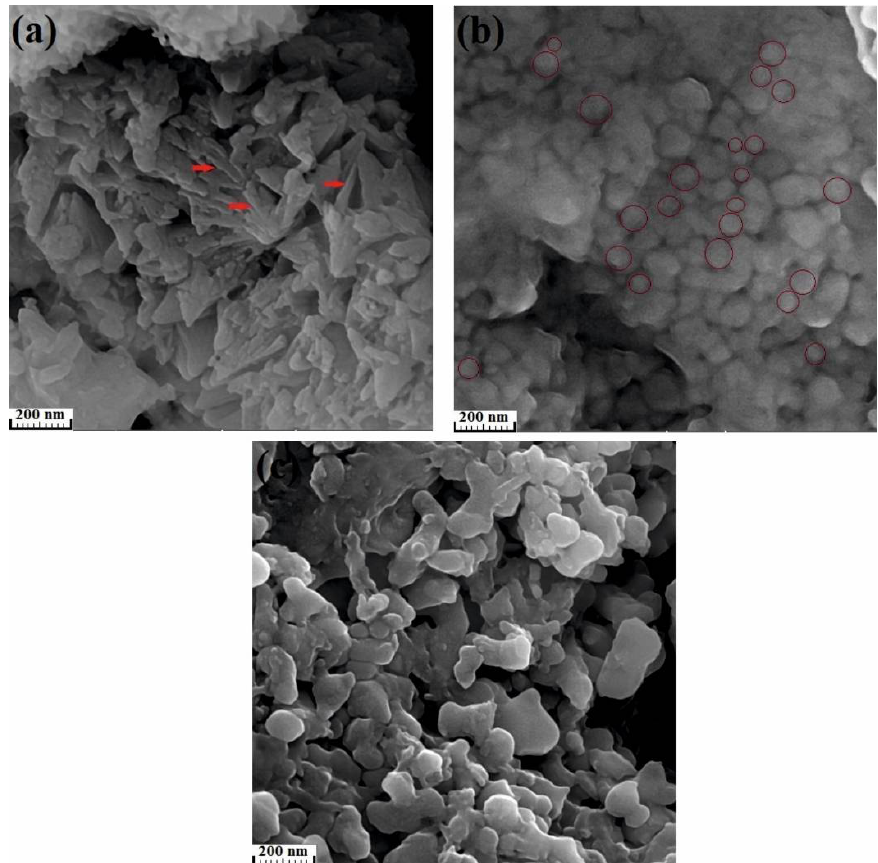
Figure 10. FE-SEM micrographs of the nanocrystalline phases formed in the amorphous matrix of (Fe 41 Co 7 Cr 15 Mo 14 Y 2 C 15 B 6 ) 100−x Cu x . ( a ) x = 0 at.% annealed up to temperature range of the first crystallization stage; ( b ) x = 0.25 at.% annealed up to temperature range of the third crystallization stage; ( c ) x = 0.5 at.% annealed up to temperature range of the fourth crystallization stage.